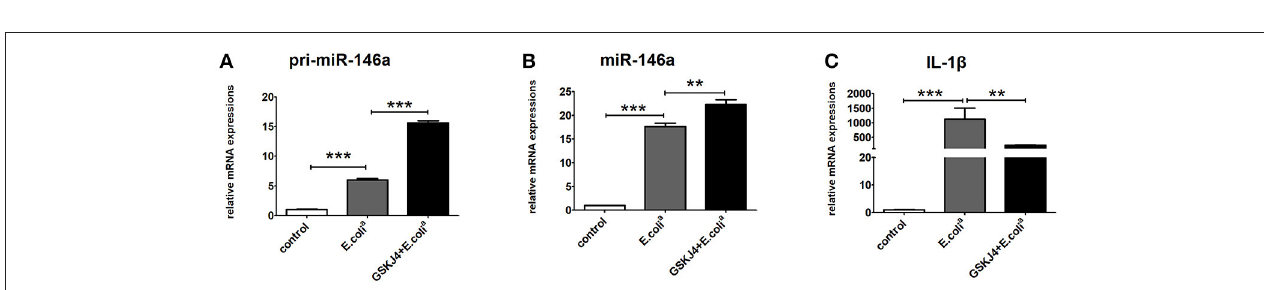
FIGURE 2 | GSKJ4 amplifies miR-146a expression under Escherichia coli (E. coli a ) -stimulation in macrophages. Raw264.7 cells were pre-treated with or without GSKJ4 (4 µ mol/L) for 1h, followed by stimulation with E. coli a (10 7 CFU/mL) for 24h. The mRNA expression levels of pri-miR-146a (A) , miR-146a (B) , and IL-1 β (C) in Raw264.7 were determined by quantitative PCR. Data are shown as mean ± SEM ( n = 3). ** P < 0.01; *** P < 0.001.